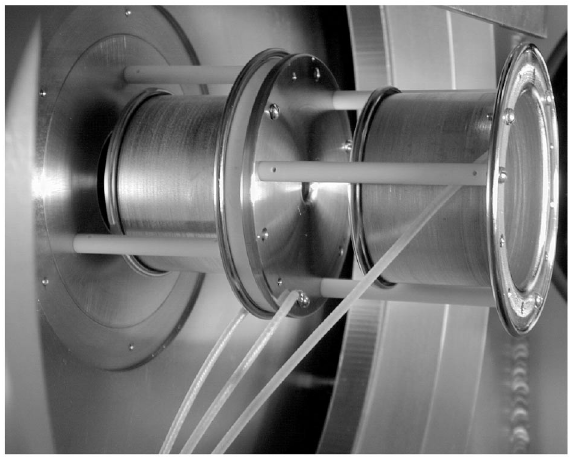
FIG. 10. Photograph of the NTX beam scraper